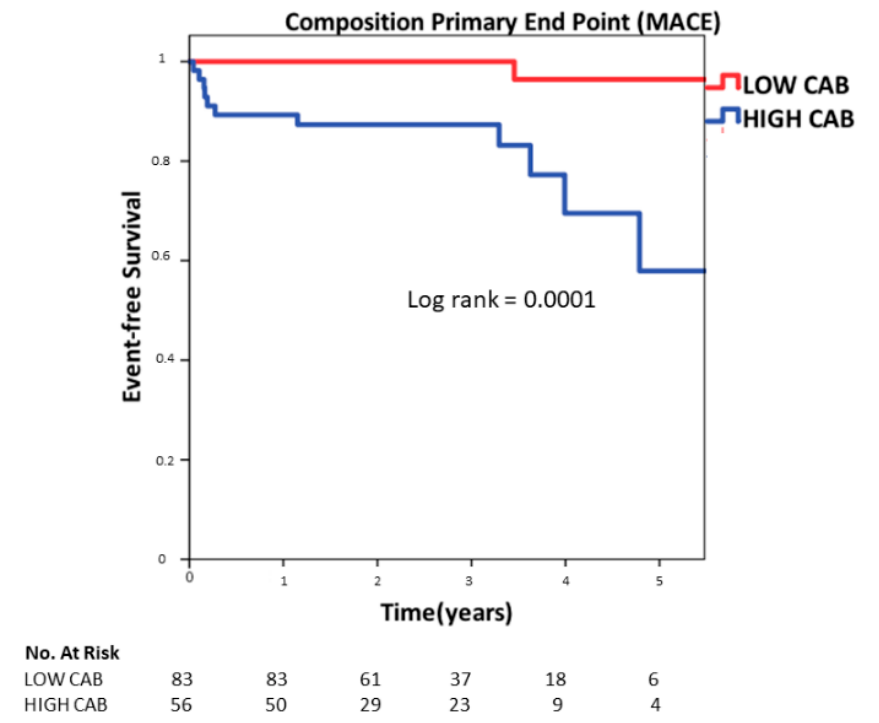
Table 3. Multivariate logistic regression analysis for MACE.